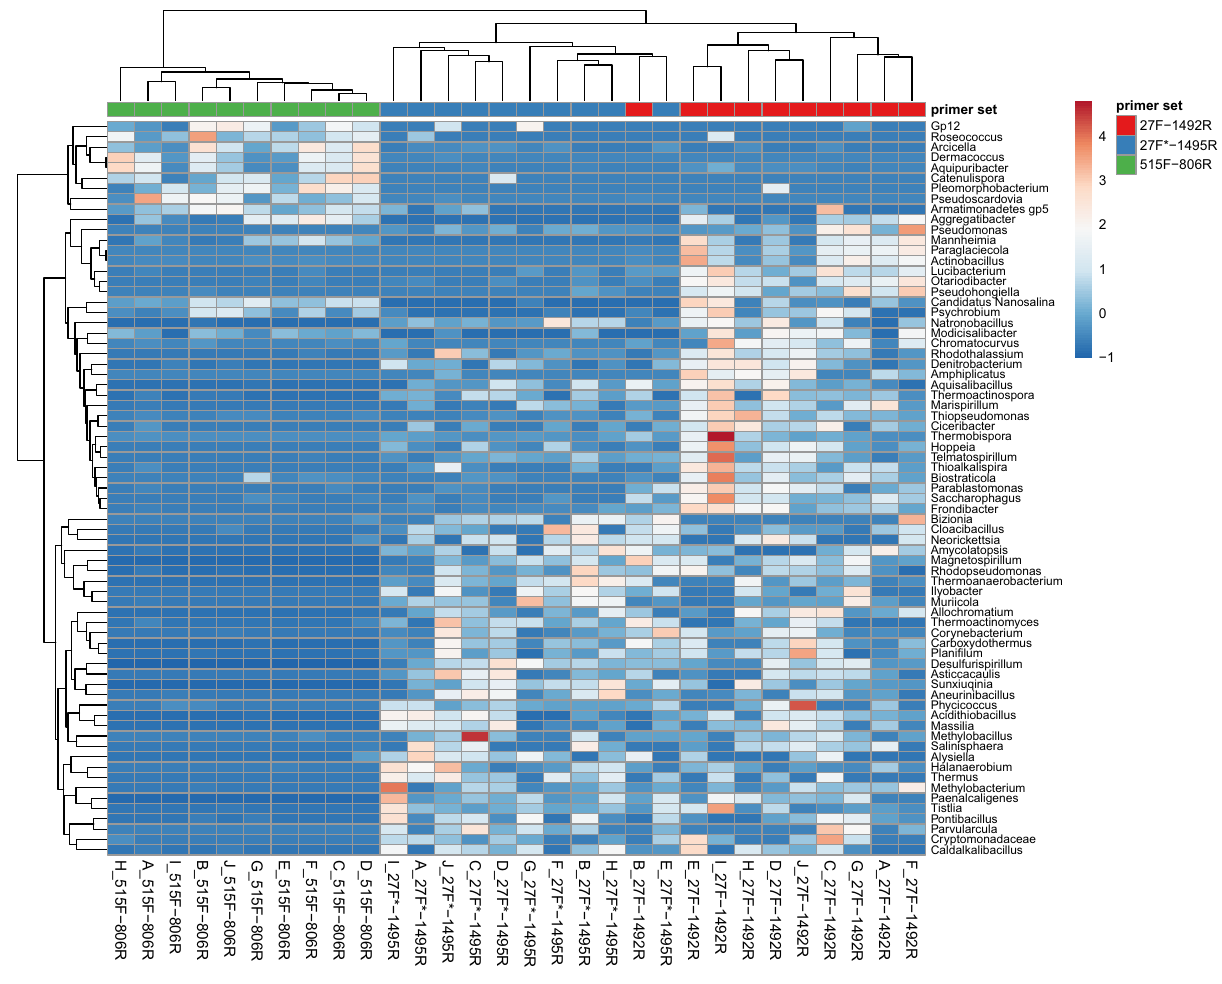
Figure 6. Comparison of the detection capability of three primer sets based on the least abundant bacterial genera with significantly different abundance among groups. For data analysis student´s t-test was performed. Bacterial genera with significantly altered abundance between compared datasets ( p ≤ 0.005) were visualized using